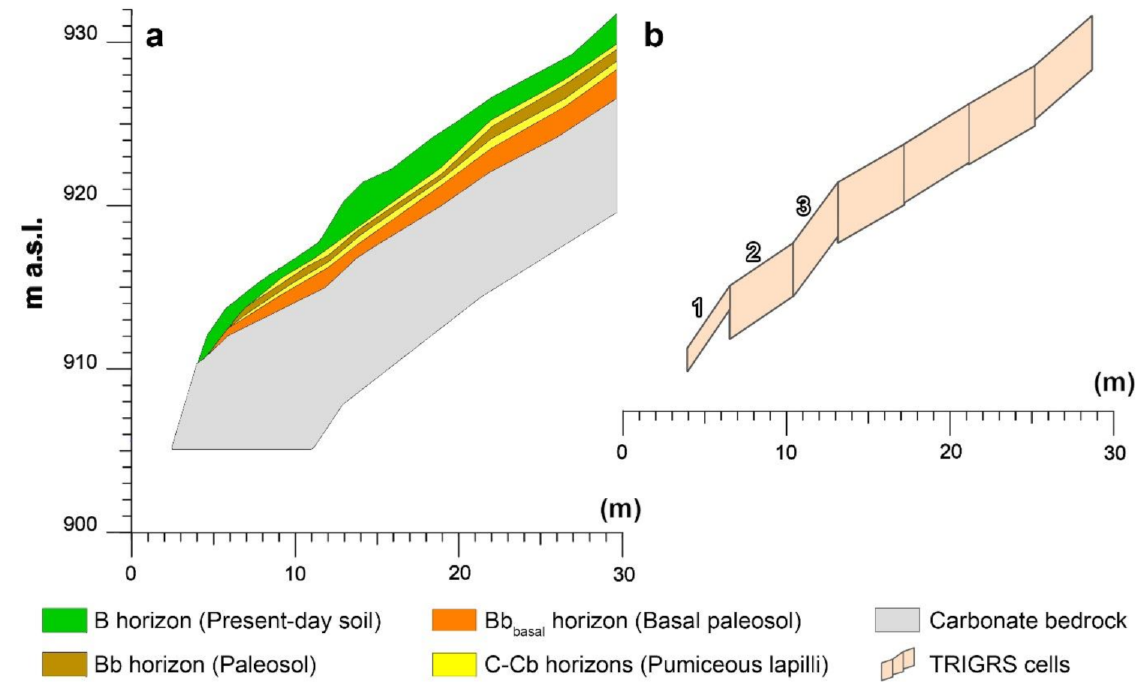
Figure 5. Simplification of a multilayered slope model, reconstructed by field surveys and used for VS2D modeling ( a ) [58,76,104] into a single-layered model with non–uniform thickness for each TRIGRS’ 5-m cell ( b ). Cells considered for TRIGRS model calibration (1, 2, 3) are also indicated ( b ) and summarized in Table